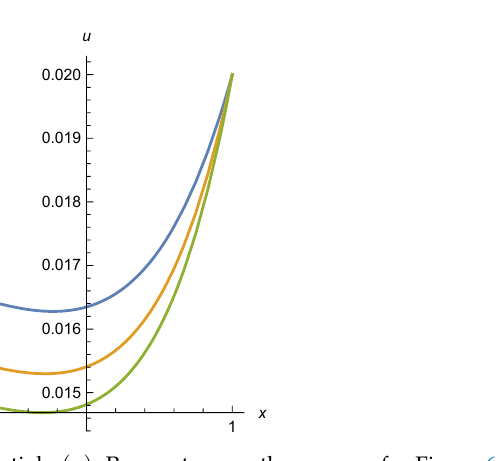
Figure 7. Minimum of effective potential u ( x ) . Parameters are the same as for Figure 6. The lowest green curve is for w 0 = 0.06, the middle orange curve for w 0 = 0.05, and the highest blue curve for w 0 =